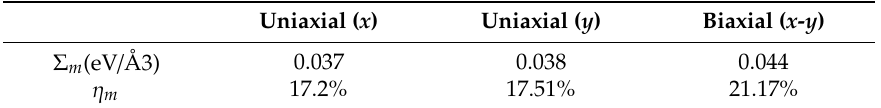
Table 2. Ultimate strains ( η m ) and ultimate stresses ( Σ m ) for three (D 1 , D 2 , and D 3 ) types of strains.